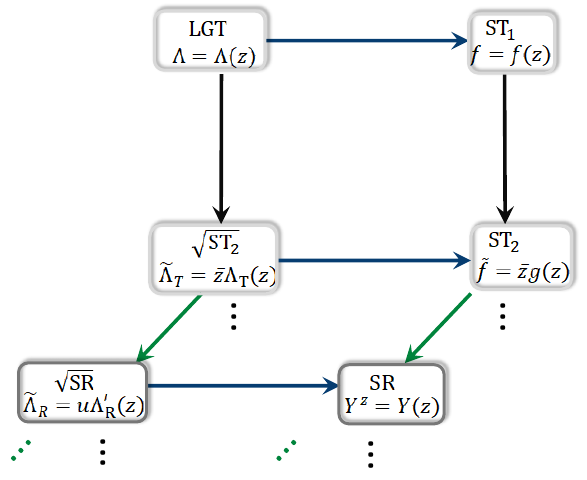
Figure 1 . Asymptotic symmetries in self-dual YM and gravity, linked by the double copy and the symmetry raising map.